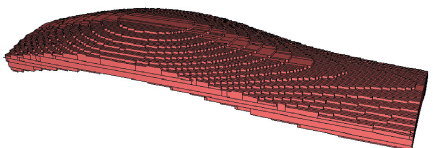
Figure 15: The optimized roof